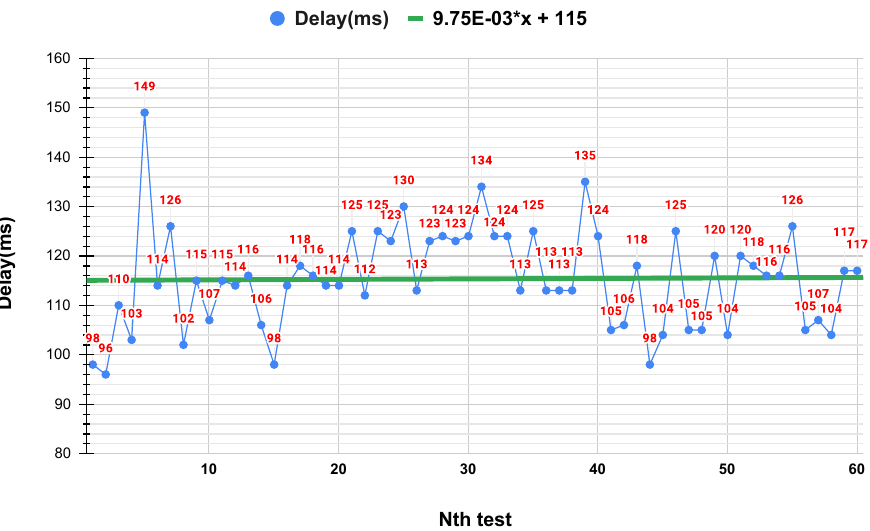
Figure 7. End-to-end delay of the proposed VR whiteboard system. The blue dots indicate the measured latency value for each test, and the green line is the fitted regression line. The y-axis ranges from 80 to 160 in order to show more details, and the regression line is almost flat, meaning that the latency of the proposed VR whiteboard is in a relatively stable